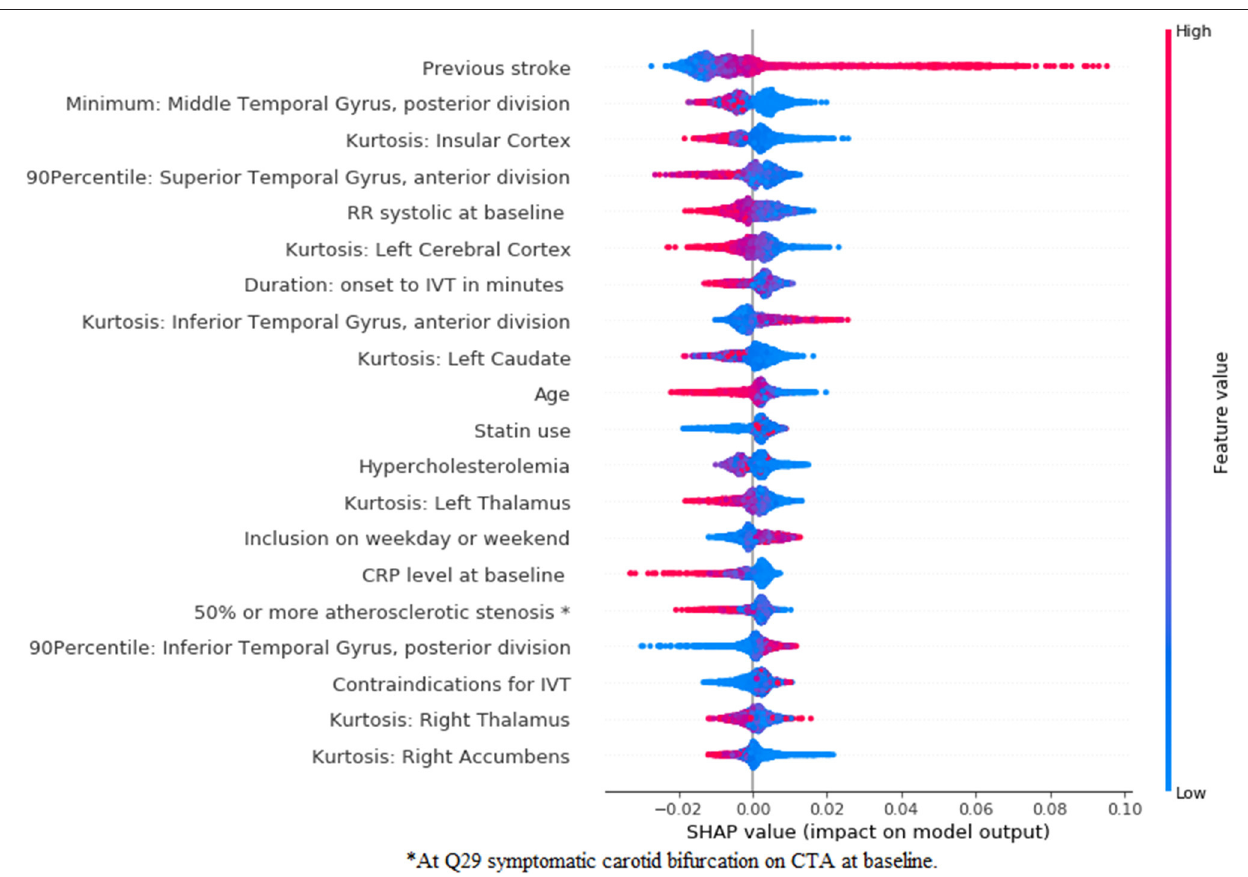
FIGURE 8 | SHapley Additive exPlanations feature importance for the combination experiment for the prediction of good reperfusion using an RFC model. For visualization purposes, we included only the top 20 features. Features are shown in order of importance, from most important (top) to less important (bottom). The color legend on the right shows how the feature values influence outcome: high values are depicted in red, while low values are presented in blue. Positive SHAP values (above zero in the x -axis) mean that the feature values are associated to the positive outcome (in this case good r), while SHAP values below zero indicate the opposite. * At symptomatic carotid bifurcation on CTA at baseline.